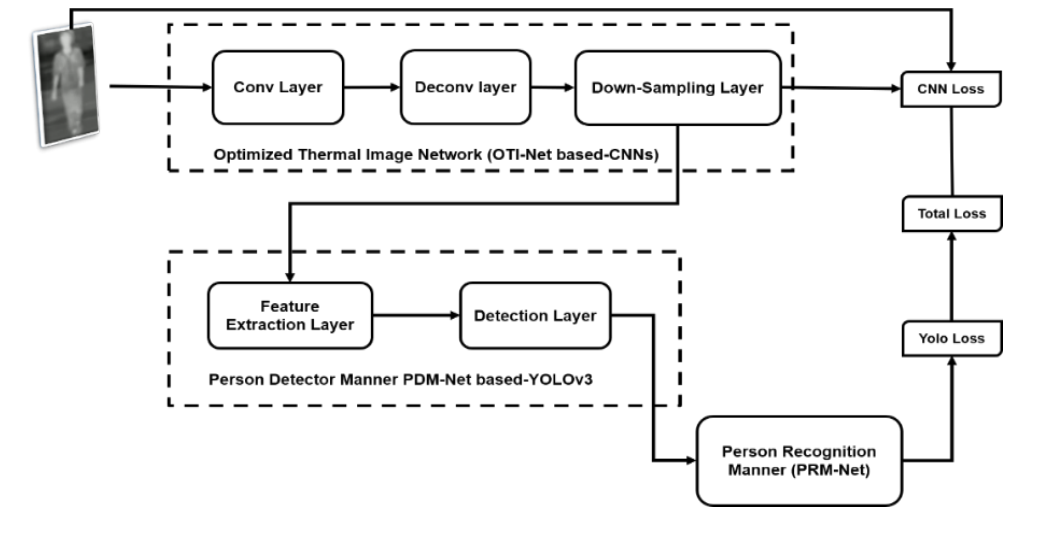
Figure 6. The block diagram of the proposed network.